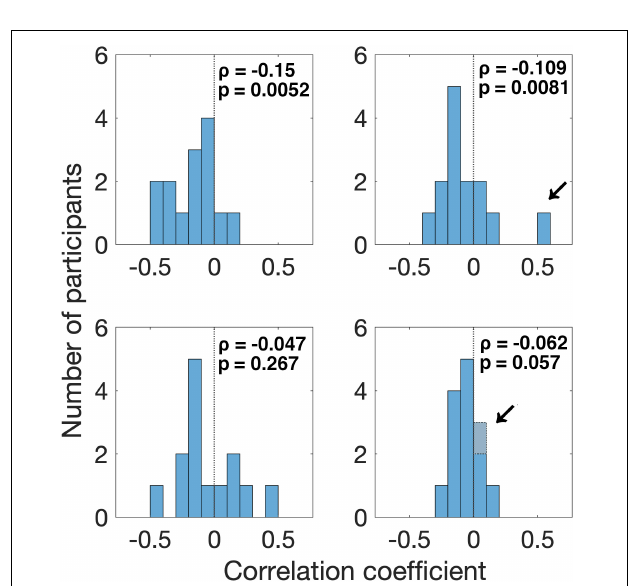
FIGURE 7 | Distribution of correlation coefficients of SRT with pre-saccade absolute pupil size and derivative for all participants. We found that a significant proportion of participants (12/14) exhibited correlation coefficients smaller than zero for the relationship between SRT and absolute pupil size, in the visual-target condition. We also found that a significant proportion of participants (11/13) exhibited correlation coefficients smaller than zero for the relationship between SRT and pupil derivative in the visual-target condition. Note that we excluded the data from one outlier participant shown by an arrow for the analysis of pupil derivative. For the auditory-target condition, the effect was marginally significant for the relationship between SRT and pupil